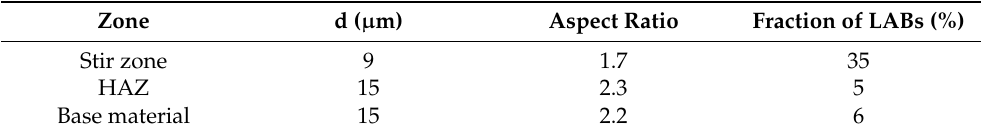
Table 1. Parameters of the microstructure determined using EBSD in the AA6061 alloy.